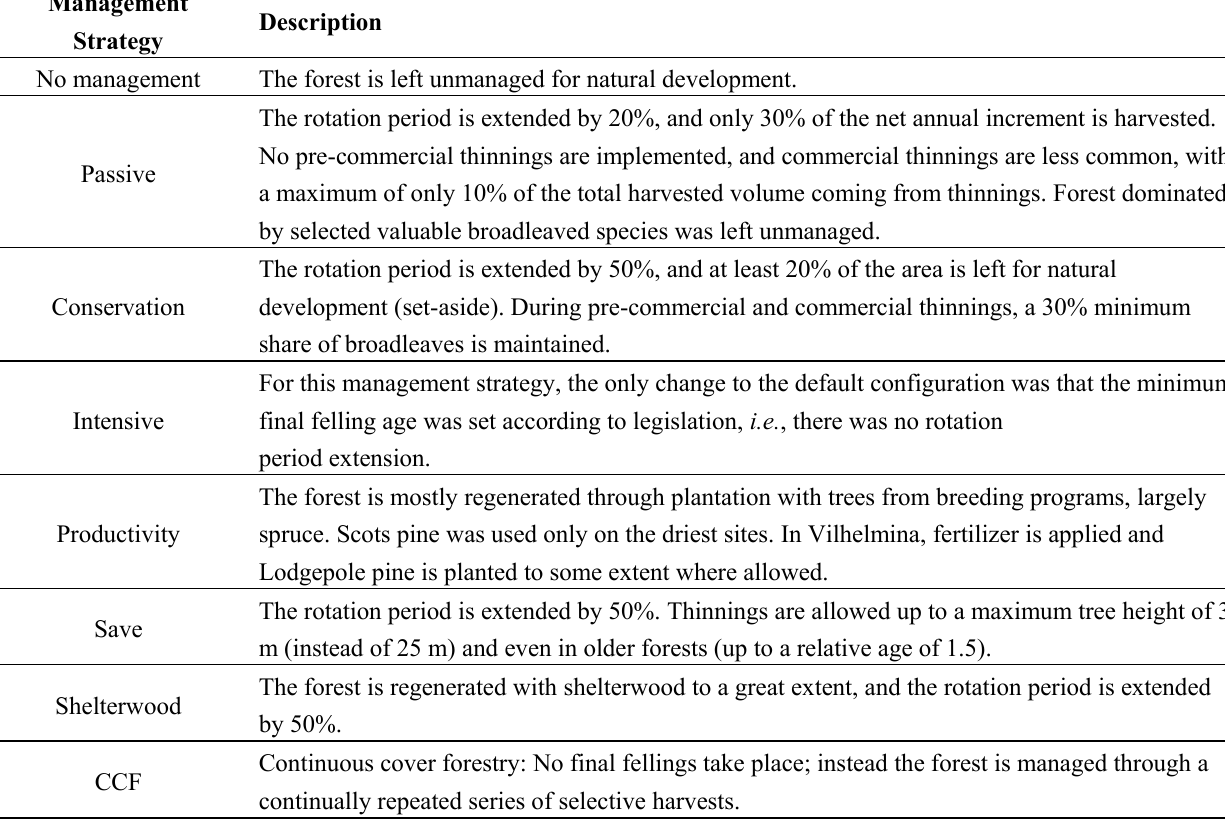
Table 6. Description of management